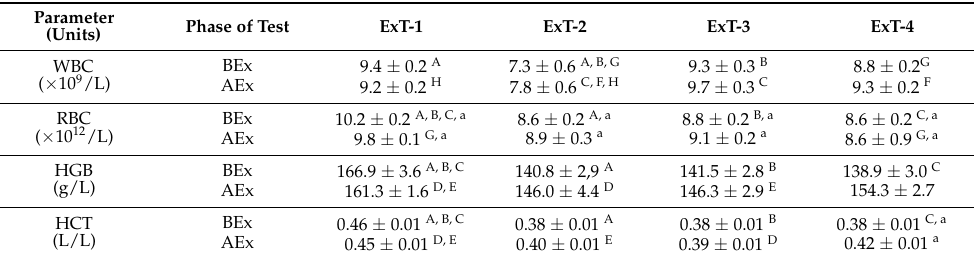
Table 7. Hematological values of measured blood parameters at rest and before and after exercise (BEx and AEx) in tests 1 to 4 (ExT-1 to